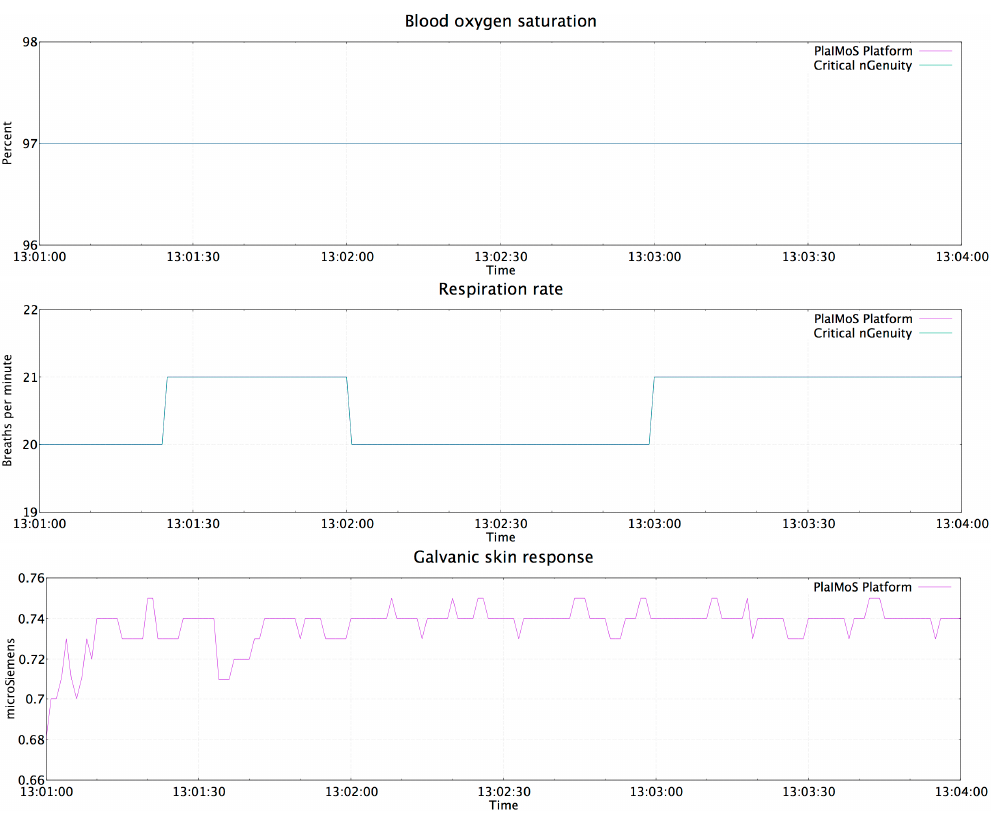
Figure 20. Values obtained by the PlaIMoS fixed measurement station.